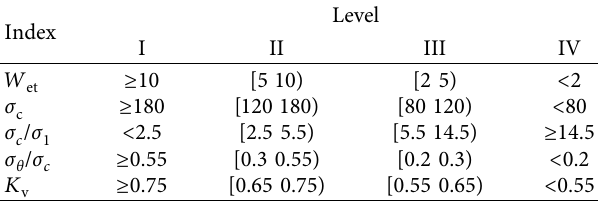
Table 1: Classification standard of rockburst